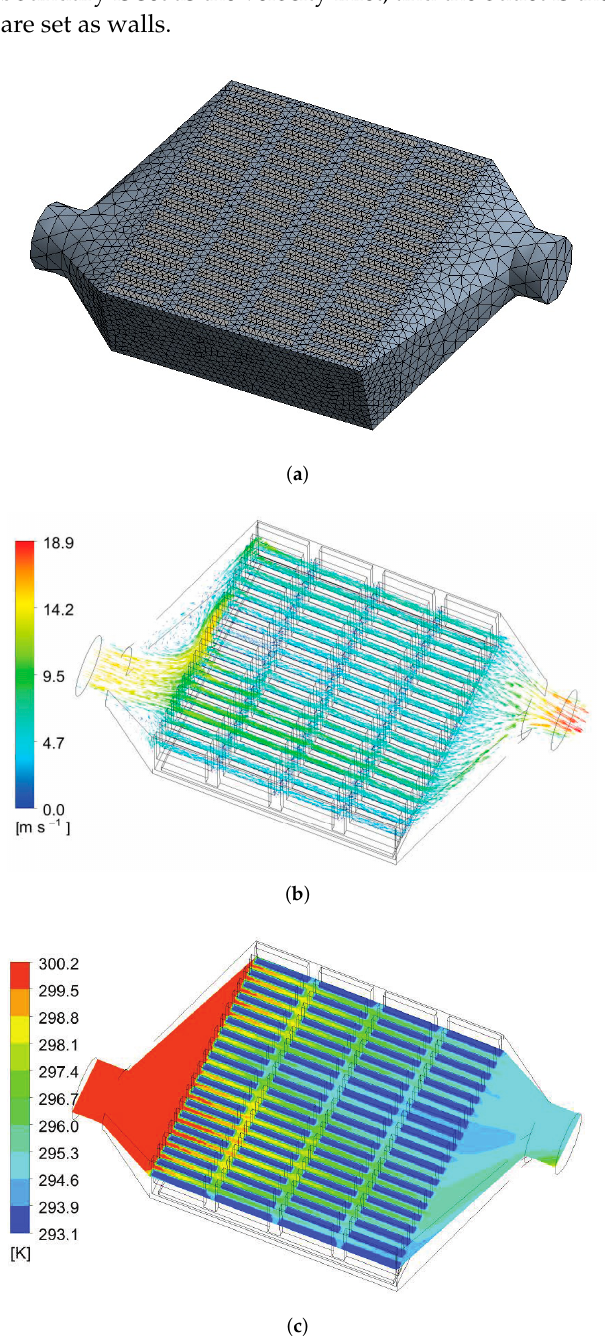
Figure 4. CFD simulation: ( a ) simulation model with meshing; ( b ) airflow velocity distribution at a height of 6 mm; ( c ) temperature distribution at a height of 6